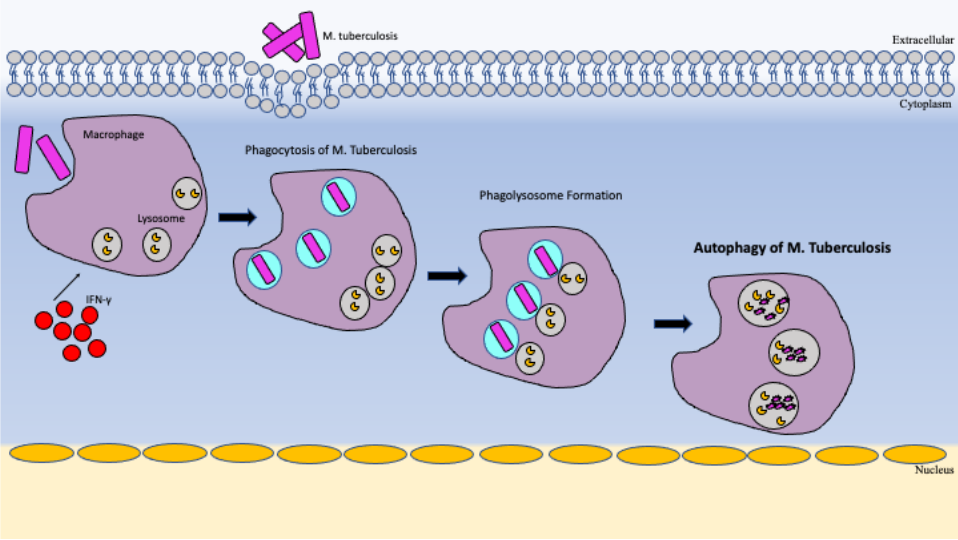
Figure 2. Autophagy of M. tb to eradicate and prevent growth.